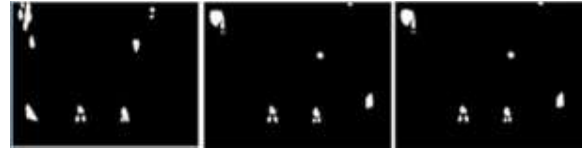
Figure 21. Applying convex hull morphological operator on Fig. 20